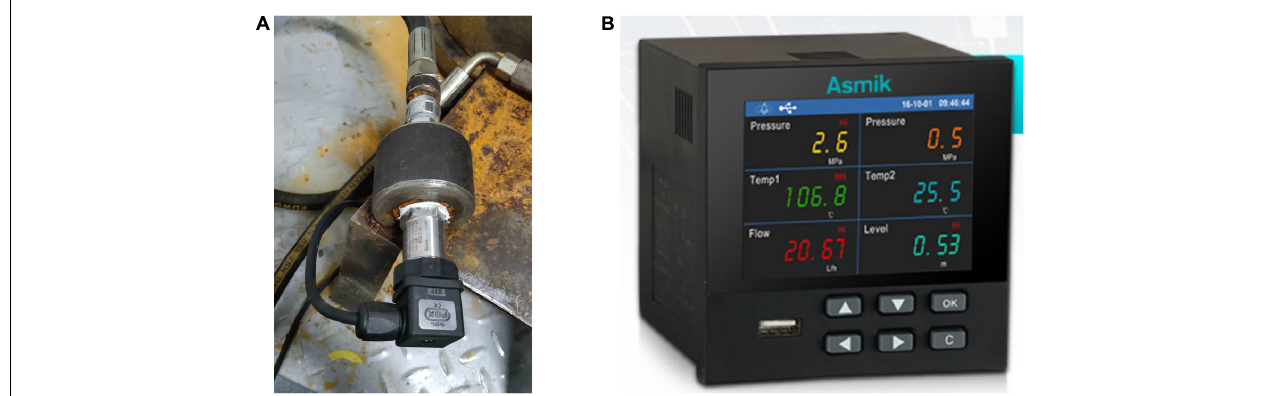
FIGURE 4 | Images of the pressure sensor (A) and recording device (B) .